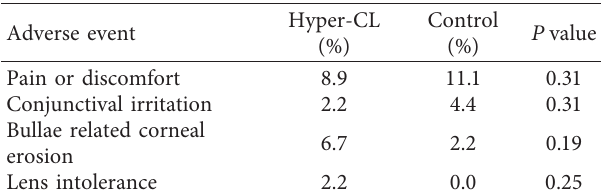
Table 2: Device-related adverse events in the Hyper-CL and bandage contact lens